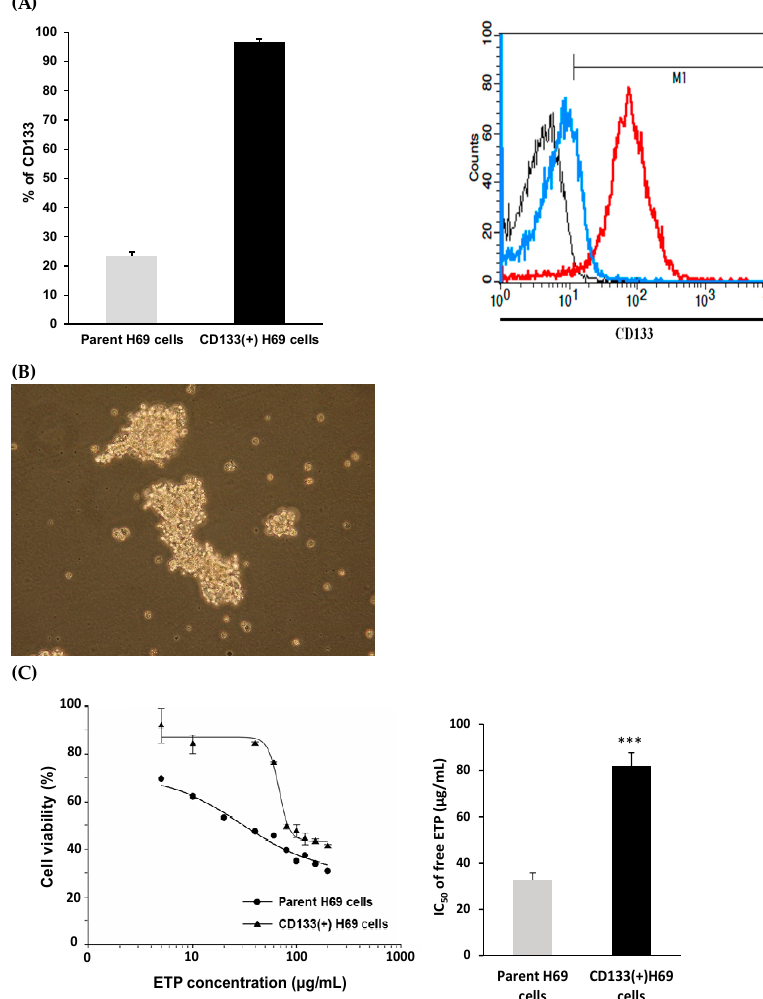
Figure 3. ( A ) CD133( + ) H69 cells after sorting with high expression of CD133. (black: isotype IgG-APC negative control; blue: CD133 expression in parent H69 cells; red: CD133 expression in CD133( + ) H69 cells. ( B ) Morphology of CD133( + ) H69 cells (40 × ). ( C ) IC 50 of ETP in CD133( + ) H69 and parent H69 cells after treated by free ETP for 72h. (*** p < 0.001, n = 3).